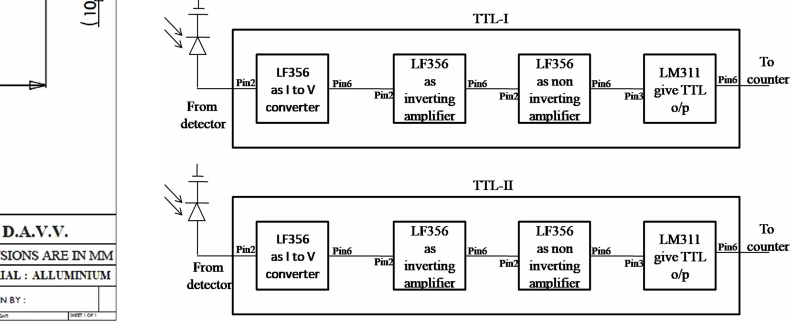
Figure 5 Block diagram of the TTL